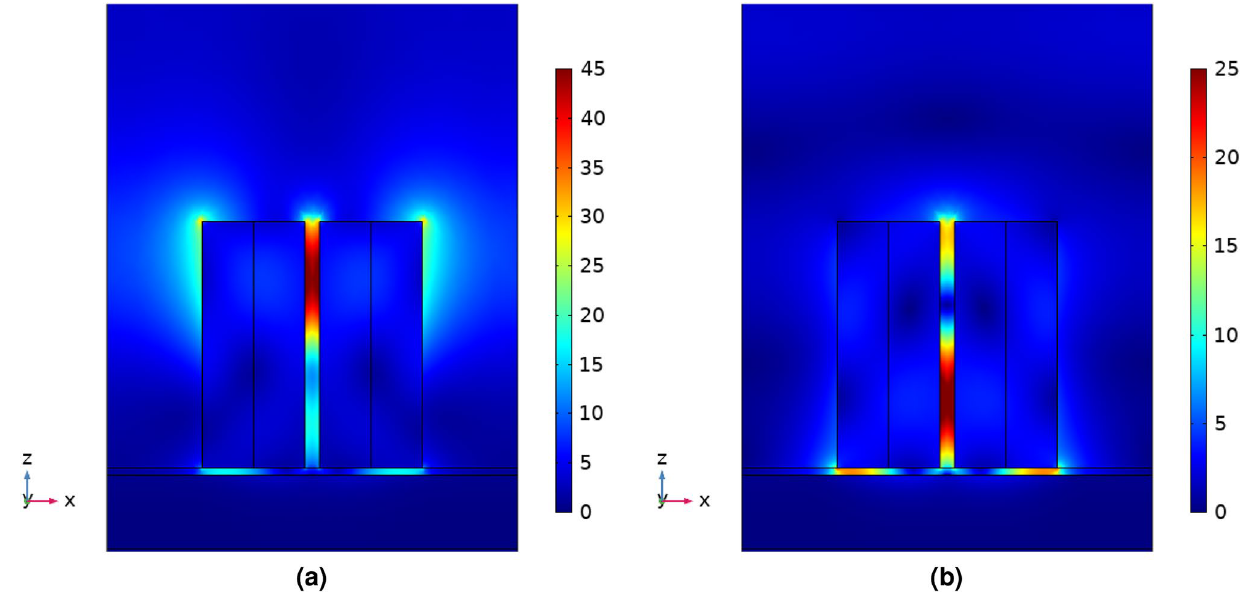
Figure 2. Scattered field magnitude when a plane wave is incident from above polarized parallel to the axis through the centre of both cylindrical nanoparticles with wavelength ( a ) 785 nm, the SERS excitation wavelength and ( b ) 850 nm, the center of the SERS emission band 16 . The spatial locations of enhanced field are almost identical to the case in air 8 , but we find that the magnitudes of enhancement are reduced, as shown in Fig. 3.